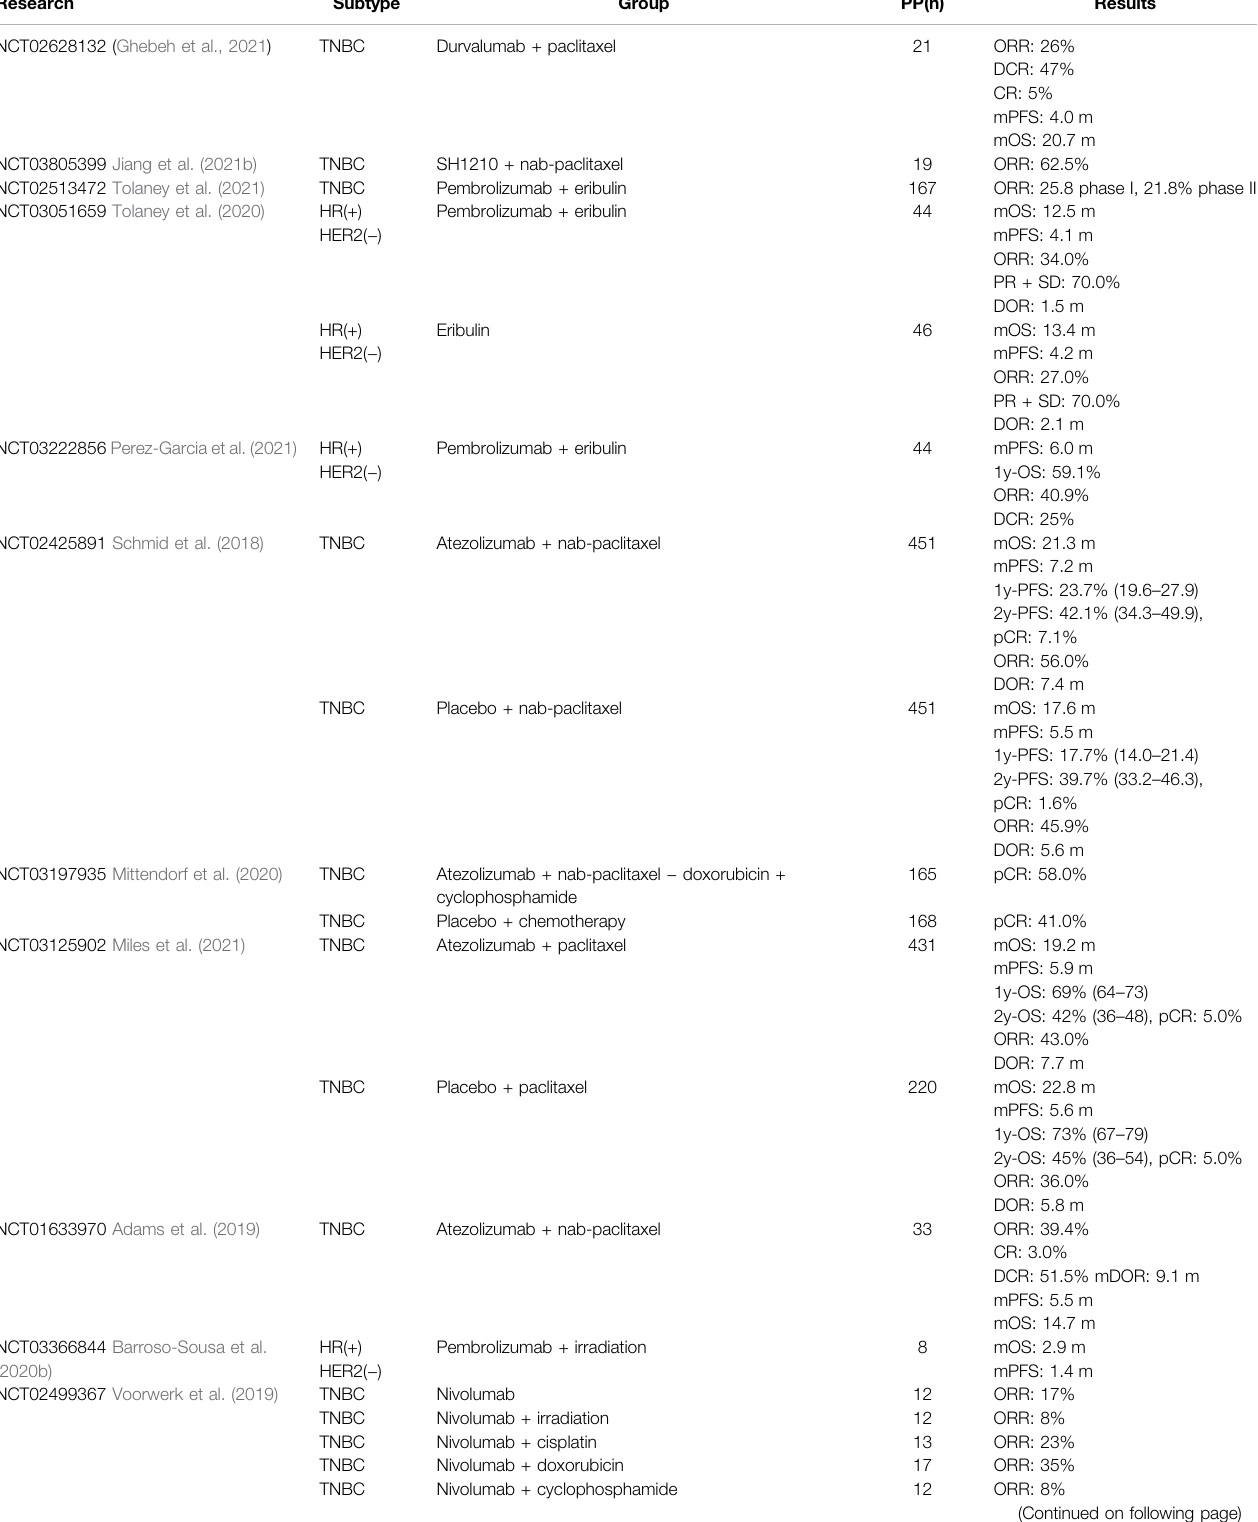
TABLE 2 | Clinical trial results of PD-1/PD-L1 blockade in combination with other cancer treatment regimens.